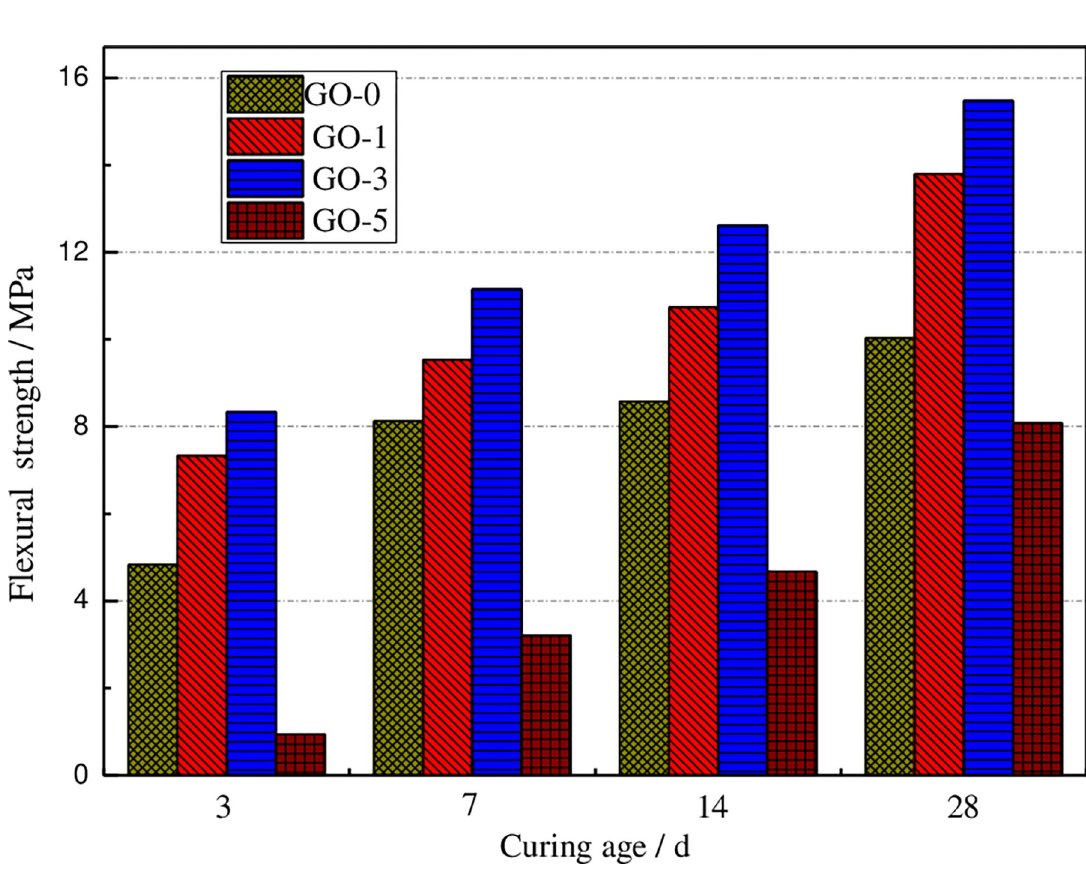
Fig 3. Flexural strength of GO cement paste under various curing ages.